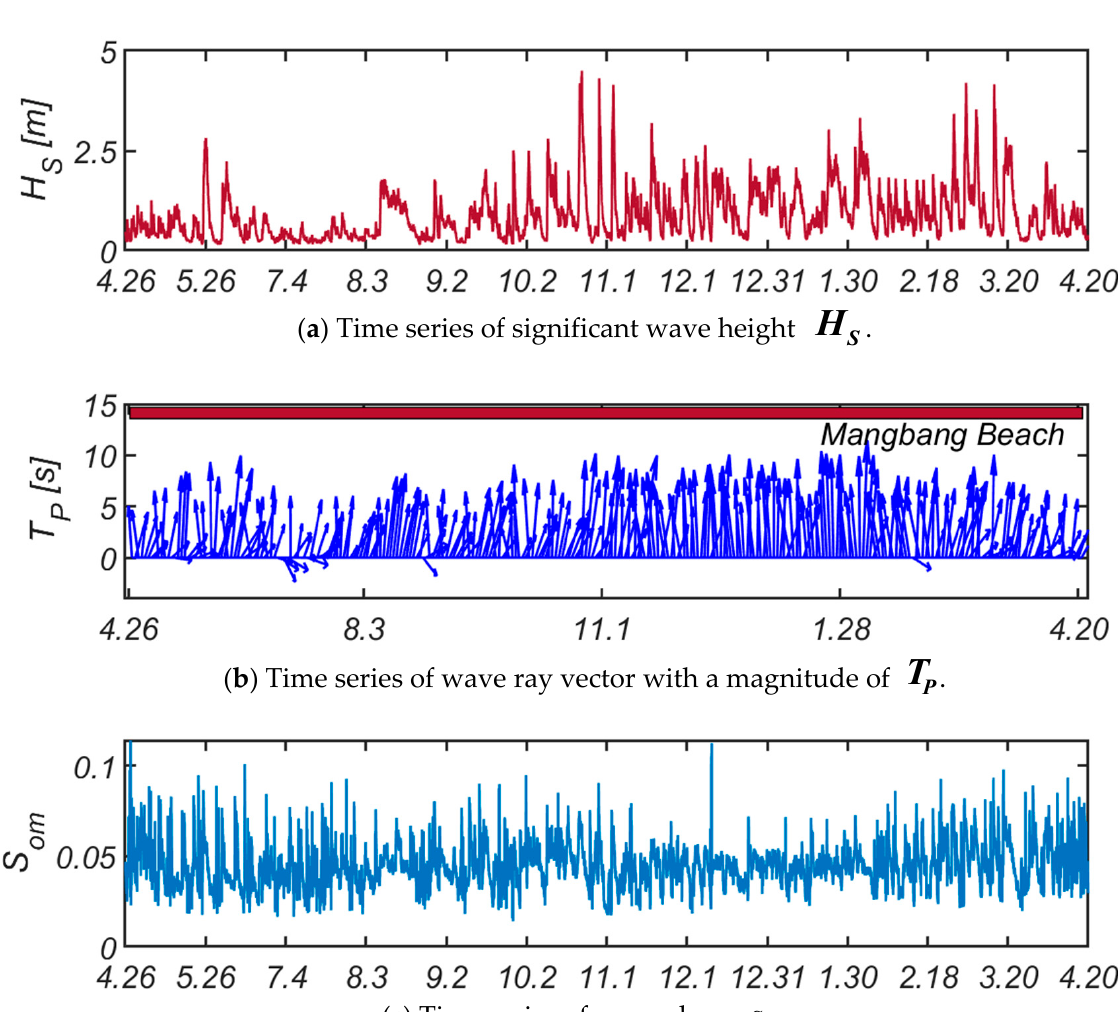
T H , significant wave height S , and wave slope S collected at Mang-Bang om